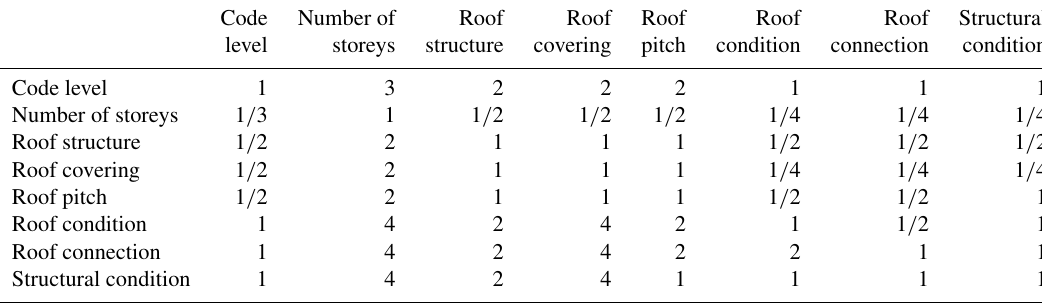
Table A5. Judgement matrix adopted for the calibration of the roof vulnerability factor weights.